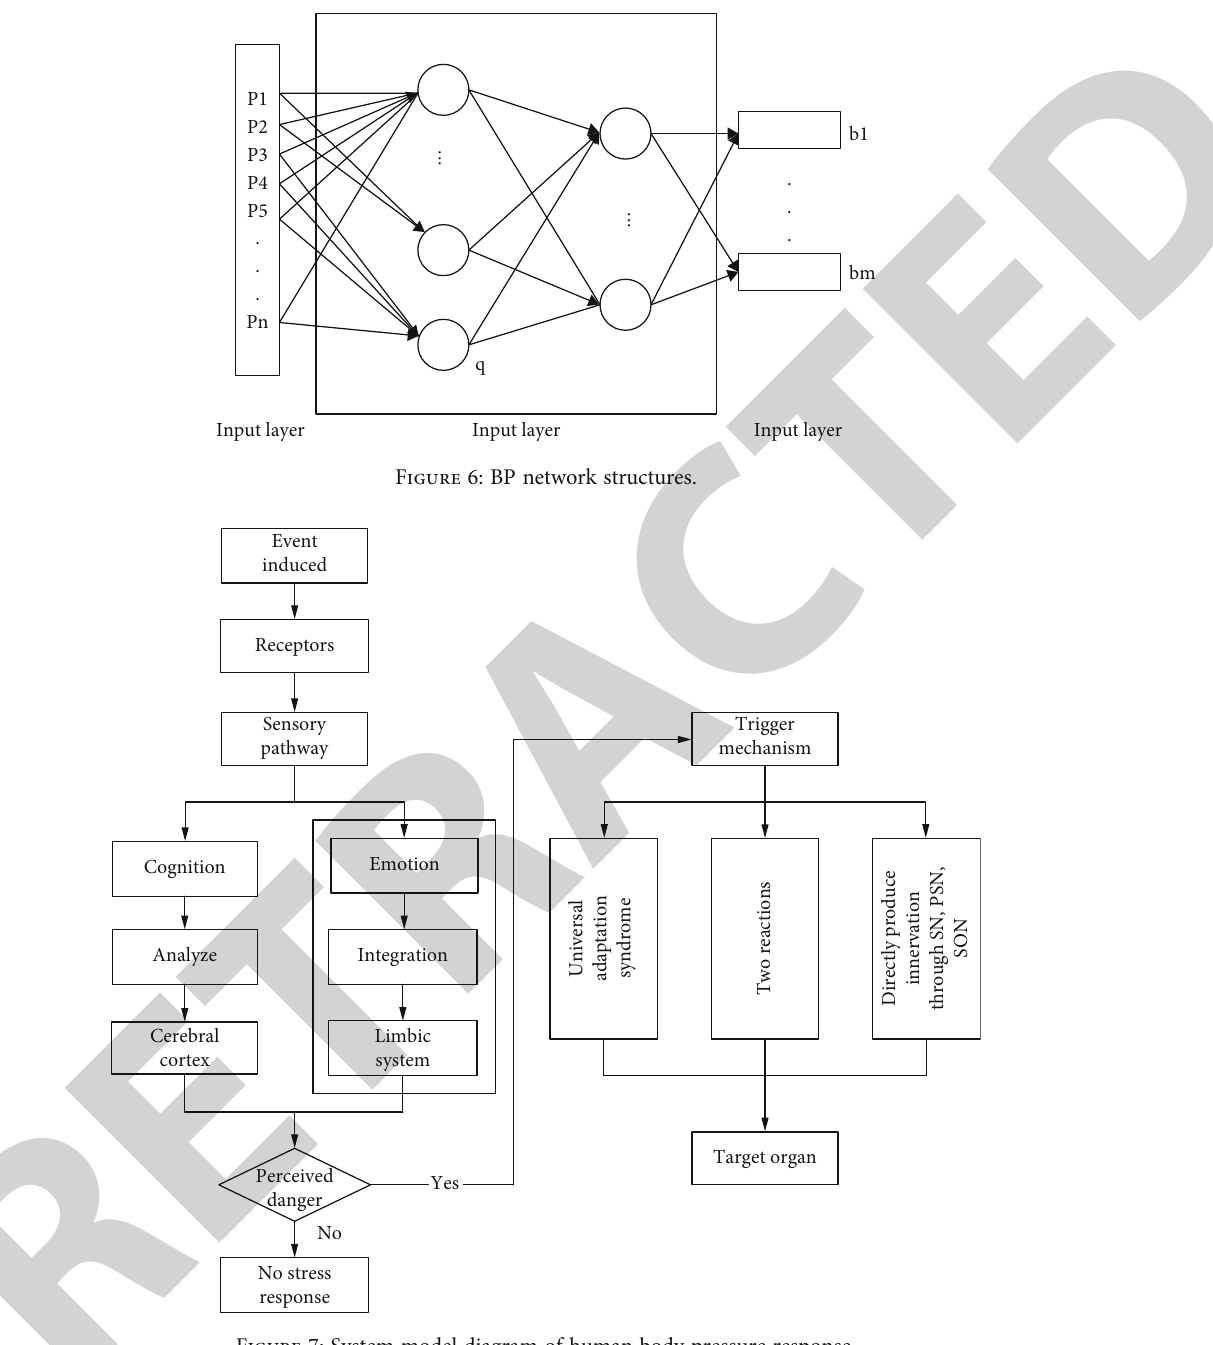
Figure 7: System model diagram of human body pressure response. Table 1: Arti fi cial neuron class fi eld and attribute description